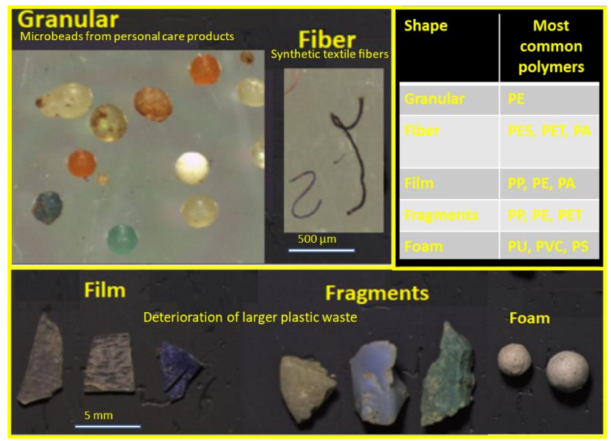
Figure 3. Common microplastic shapes and related materials (Elaborated from